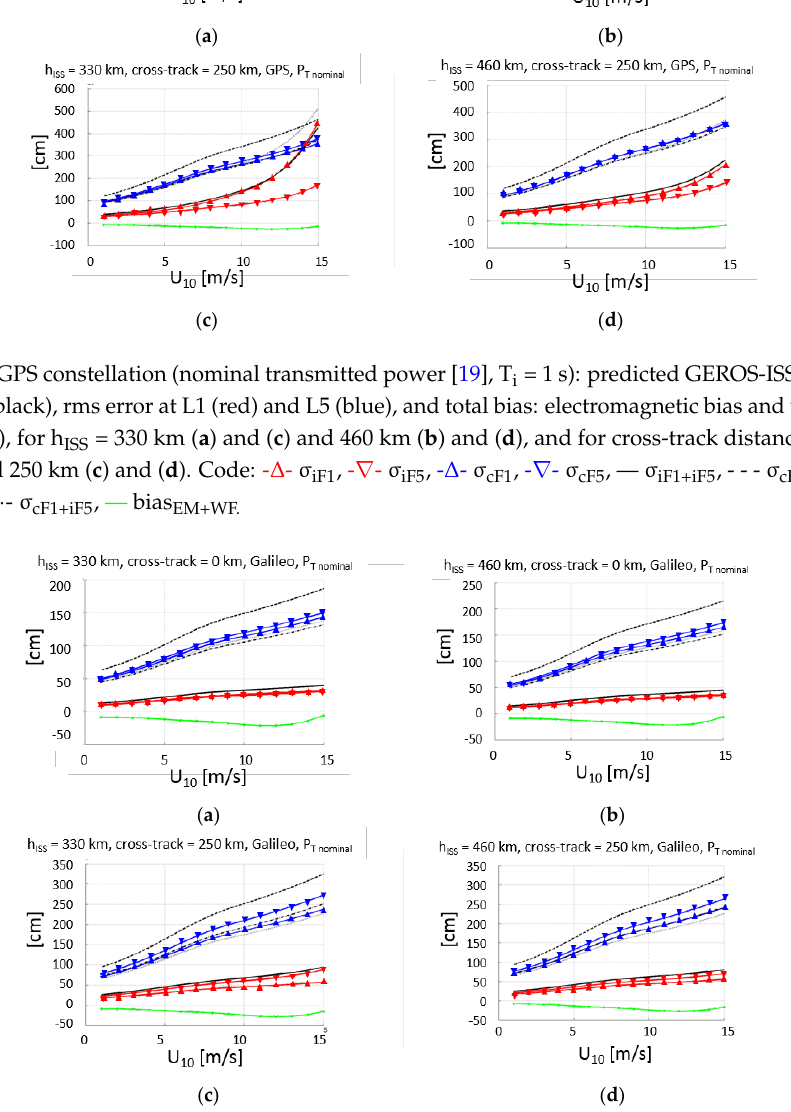
Figure 14 Figure 14. Galileo constellation (nominal transmitted power [20], T i = 1 s): predicted GEROS-ISS altimetry rms error (black), rms error at L1 (red) and L5 (blue), and total bias: electromagnetic bias and waveform bias (green), for h ISS = 330 km ( a ) and ( c ) and 460 km ( b ) and ( d ), and for cross-track distance 0 km ( a ) and ( b ) and 250 km ( c ) and ( d ). Code: - ∆ - σ iF1 , - ∇ - σ iF5 , - ∆ - σ cF1 , - ∇ - σ cF5 , — σ iF1+iF5 , - - - σ cF1+cF5 , ····· σ iF1+cF5 , - · - · - σ cF1+iF5 , — bias EM+WF